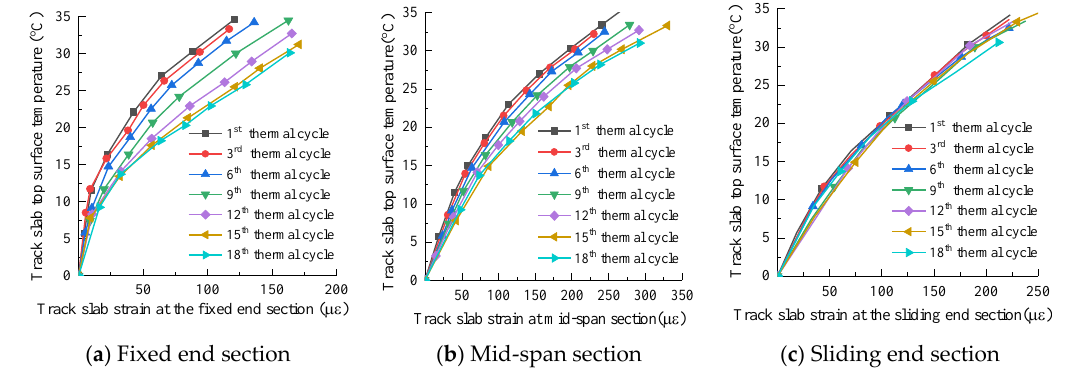
Figure 11. Track slab strain variation with the thermal load.